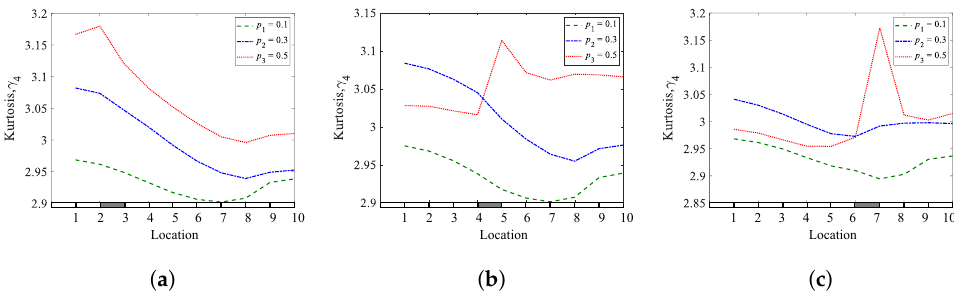
Figure 20. Kurtosis coefficients of a simply supported beam for different crack depths and locations: ( a ) q 1 = 0.25; ( b ) q 2 = 0.45; ( c ) q 3 = 0.65.